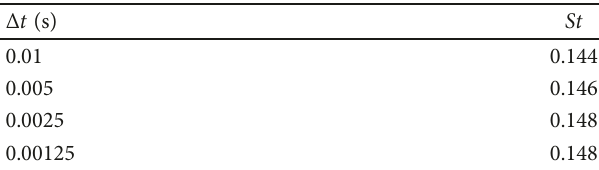
Table 3: Time step sensitivity